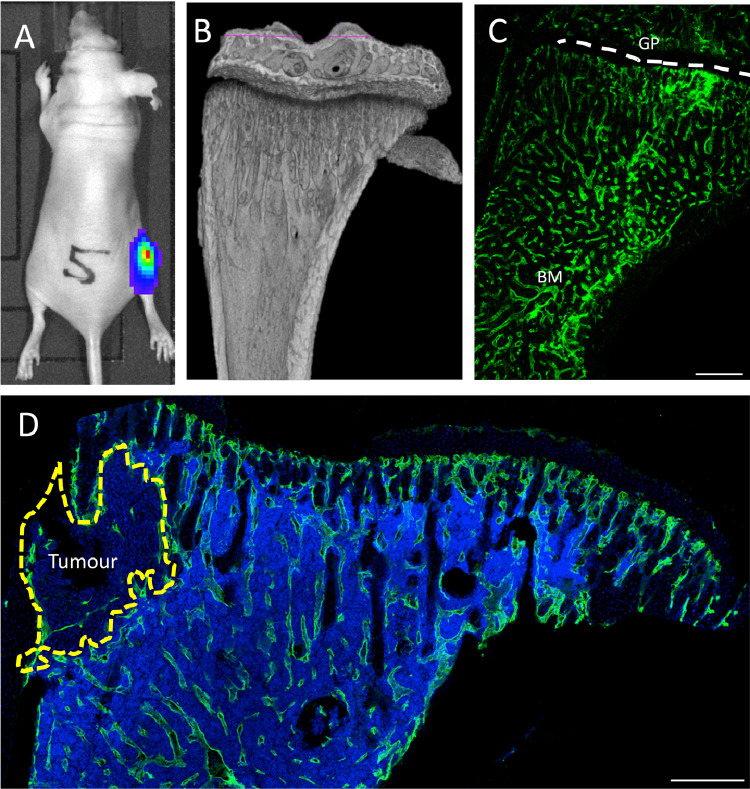
In vivo tumour model and location of the bone metastatic niche. (A) Representative image of the breast cancer bone metastasis animal model. Female BALB/c nude mice were injected i.c. MDA-MB-231-GFP cells transfected with luciferase, tumour growth was detected in the hind limbs using an in vivo imaging system (IVIS). (B) Representative micro-computed tomography reconstruction illustrating the trabecular architecture of the tibia. (C) Immunofluorescence staining using antibody against the endothelial marker endomucin to visualise the extensive microvascular network of long bones. (D) Immunofluorescence staining of a tumour bearing tibial section using an antibody specific for the endothelial cell marker endomucin. Dotted yellow line = tumour outline, BM = bone marrow, GP = growth plate, green = Endomucin and blue = DAPI, scale bar = 200um. (For interpretation of the references to color in this figure legend, the reader is referred to the web version of this article.)